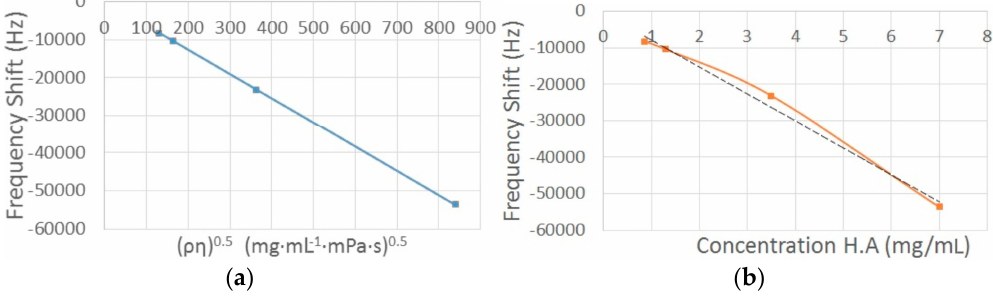
Figure 8. Response curve of the QCR biosensor vs. the square root of the density-viscosity product ( a ) and Response curve of the QCR biosensor vs. concentration ( b ).